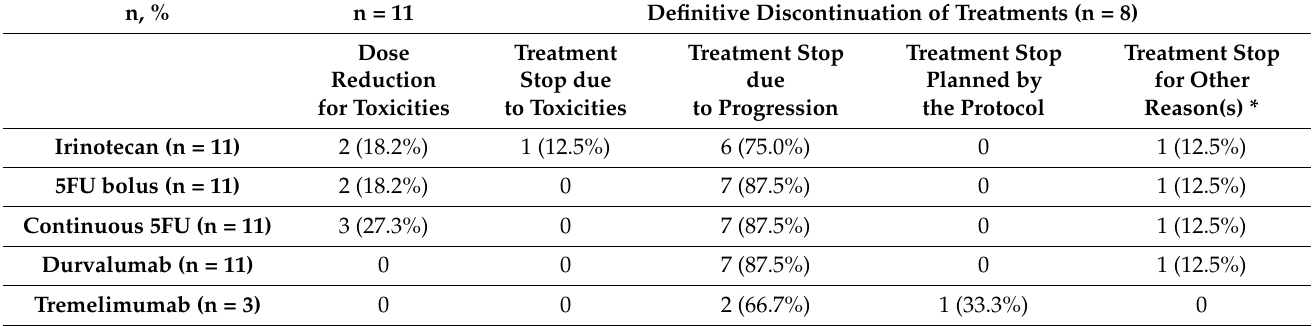
Table 3. Dose reduction and treatment